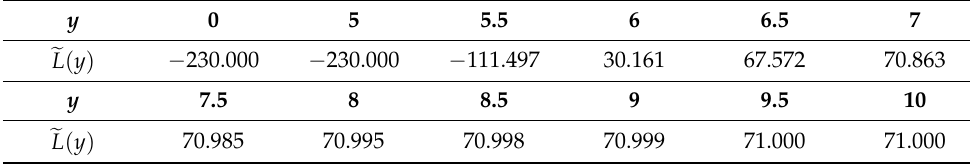
Table 1. Changes of quality gain-loss function (cid:101) L ( y )